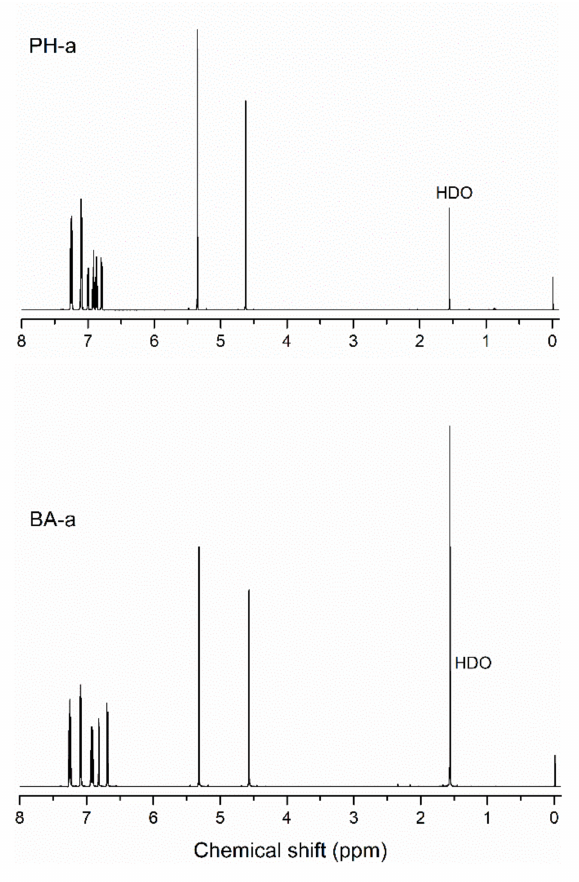
Figure 5. NMR spectra of PH-a and BA-a from 2-(aminomethyl)phenol.